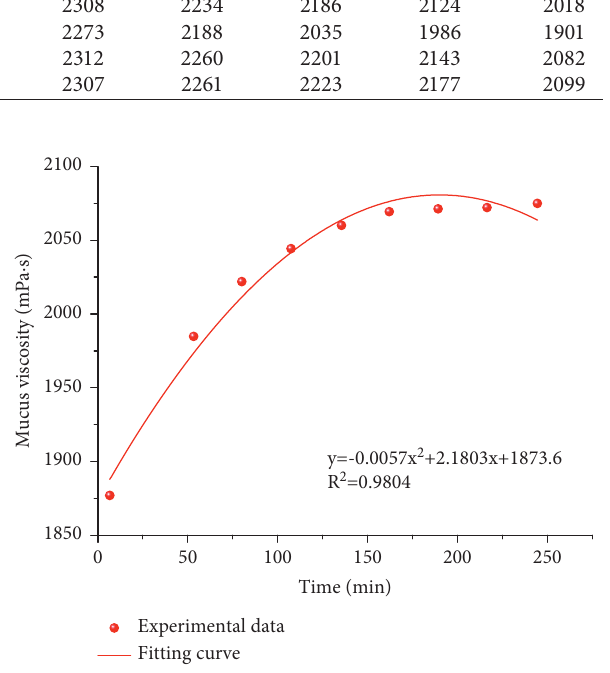
Figure 3: Variation curve of CMC-Na solution viscosity with swelling